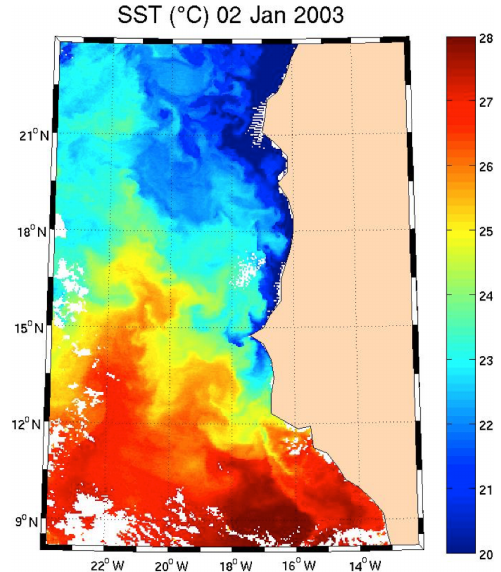
Figure 9. SST for 2 January 2003. Note the well-marked upwelling (cold temperature) north of 13 ◦